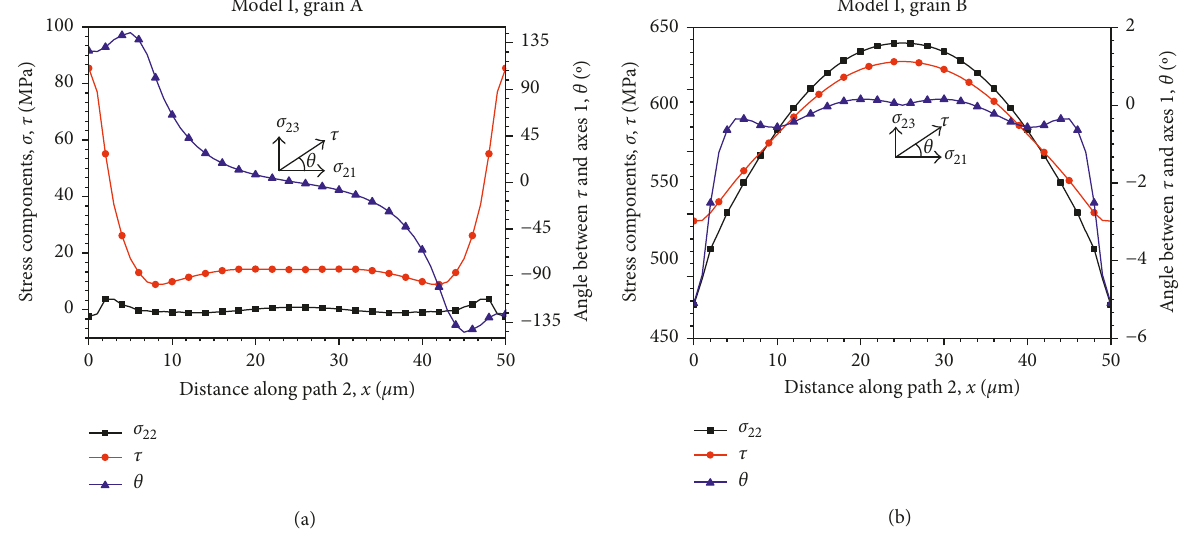
Figure 14: Stress components on model I GB: (a) grain A and (b) grain